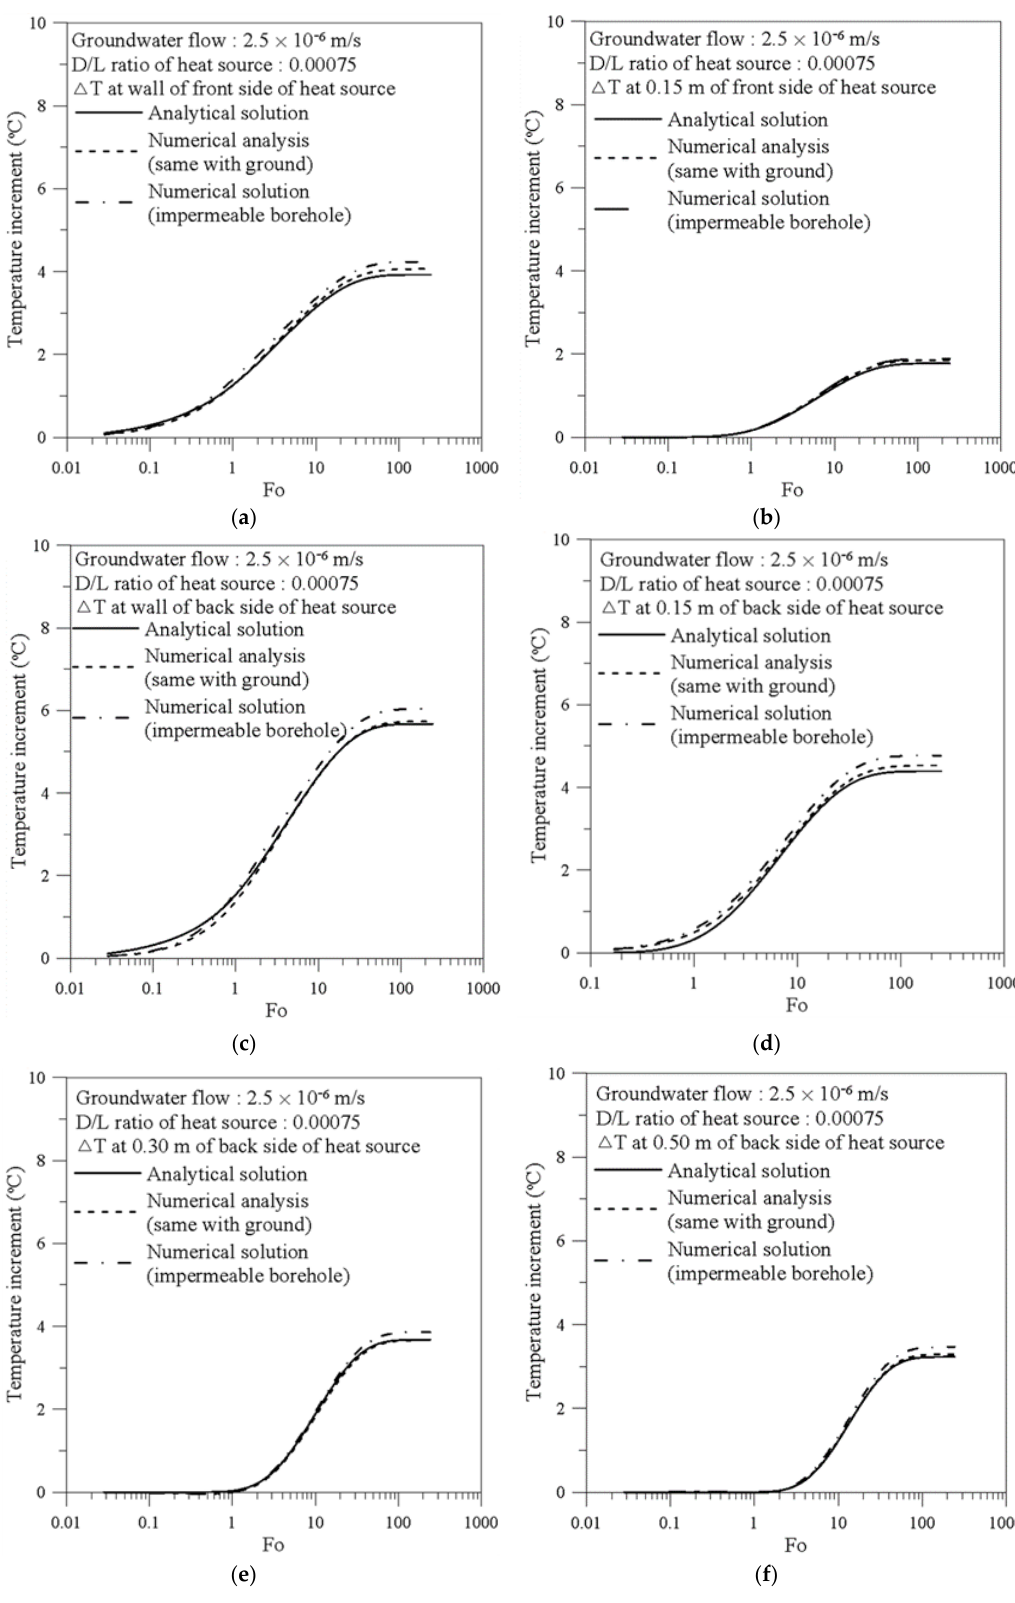
Figure 8. Comparison of analytical solution and numerical analysis results (u = 2.5 × 10 −6 m/s, D/L ratio = 0.00075). Temperature increment at ( a ) wall of front side; ( b ) 0.15 m of front side; ( c ) wall of back side; ( d ) 0.15 m of back side; ( e ) 0.30 m of back side; ( f ) 0.50 m of back side.